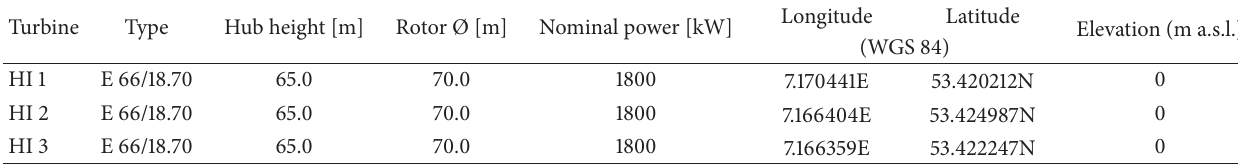
Table 1: Coordinates and data of the wind turbines at the site Hinte .